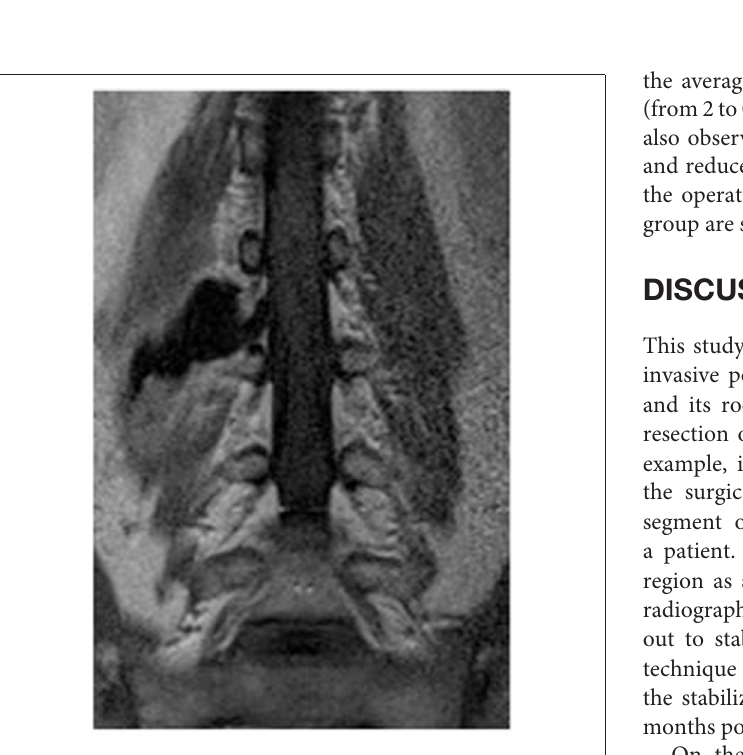
FIGURE 6 | MRI of the lumbar spine with contrast after the surgery.